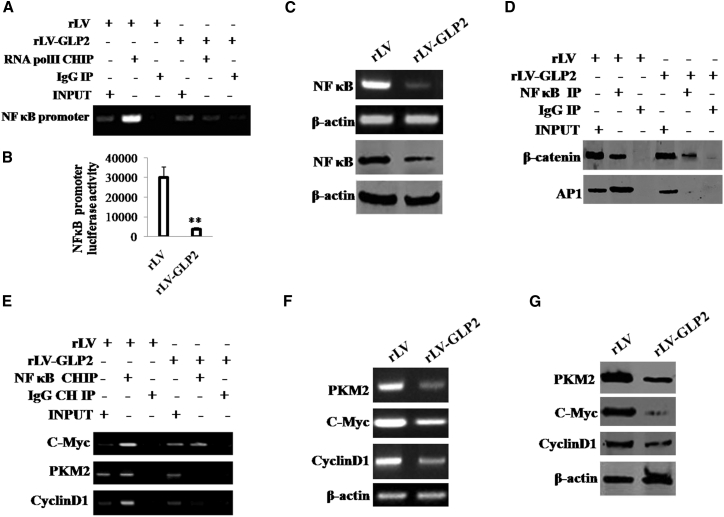
GLP2 Inhibits the Expression of NF-κB in MG63(A) ChIP assay with anti-RNA polII followed by PCR with promoter DNA primers of NF-κB in MG63 cells infected with rLV-GLP2 or rLV. IgG ChIP was the negative control. NF-κB promoter as INPUT. (B) The assay of luciferase activity of prmoter of NF-κB in MG63 infected with rLV-GLP2 or rLV, respectively. Data are means of value from three independent experiment (error bar ± SEM; **p < 0.01). (C) Western blotting with anti-NF-κB and RT-PCR with NF-κB primers in MG63 infected with rLV-GLP2 or rLV. β-actin as internal control. (D) Co-immunoprecipitation (coIP) with anti-NF-κB followed by western blotting with anti-β-catenin and anti-AP1 in MG63 infected with rLV-GLP2 or rLV, respectively. IgG IP was used as a negative control. INPUT refers to western blotting with anti-β-catenin and anti-AP1. (E) ChIP assay with anti-NF-κB followed by PCR with DNA primers (promoter region) of c-Myc,PKM2, CyclinD1 in MG63 cells infected with rLV-GLP2 or rLV. IgG ChIP was the negative control. The promoters of c-Myc, PKM2, CyclinD1 as INPUT. (F) RT-PCR with primers of c-Myc, PKM2, CyclinD1 in MG63 infected with rLV-GLP2 or rLV. β-actin as internal control. (G) Western blotting with anti-c-Myc, anti-PKM2, anti-CyclinD1 in MG63 infected with rLV-GLP2 or rLV. β-actin as internal control.